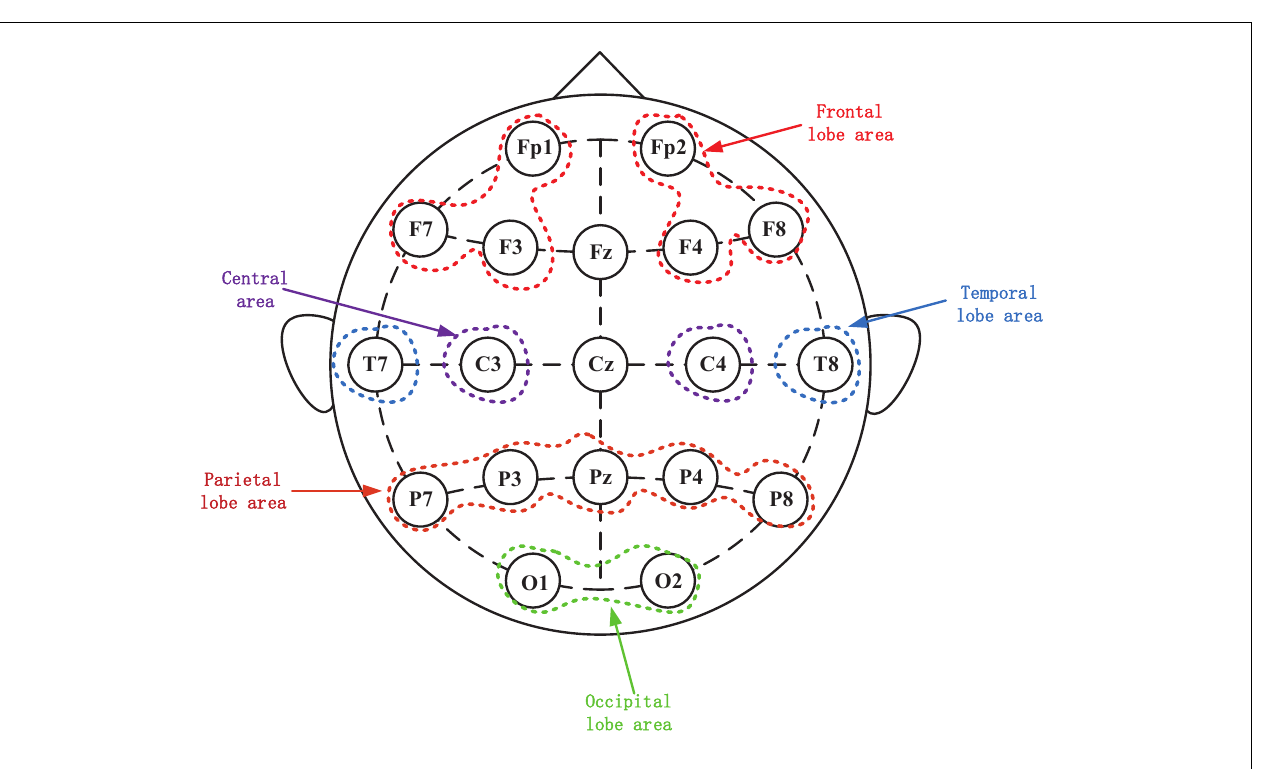
people are in a relaxed, calm but awake state; Theta